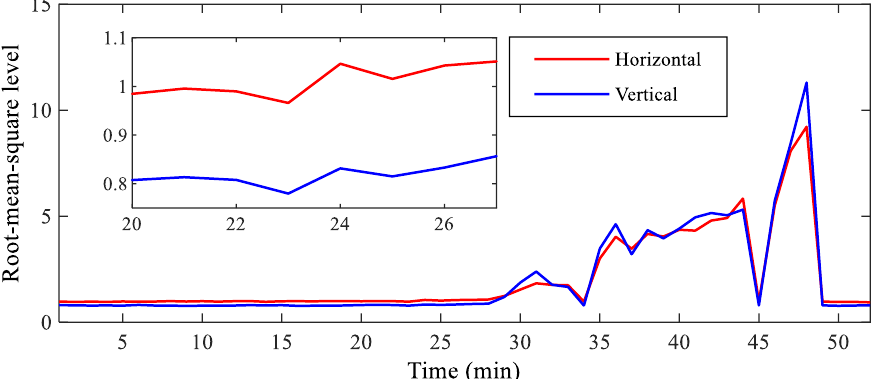
Figure 4. Horizontal and vertical RMS indicators of the tested bearing throughout its whole operating life.